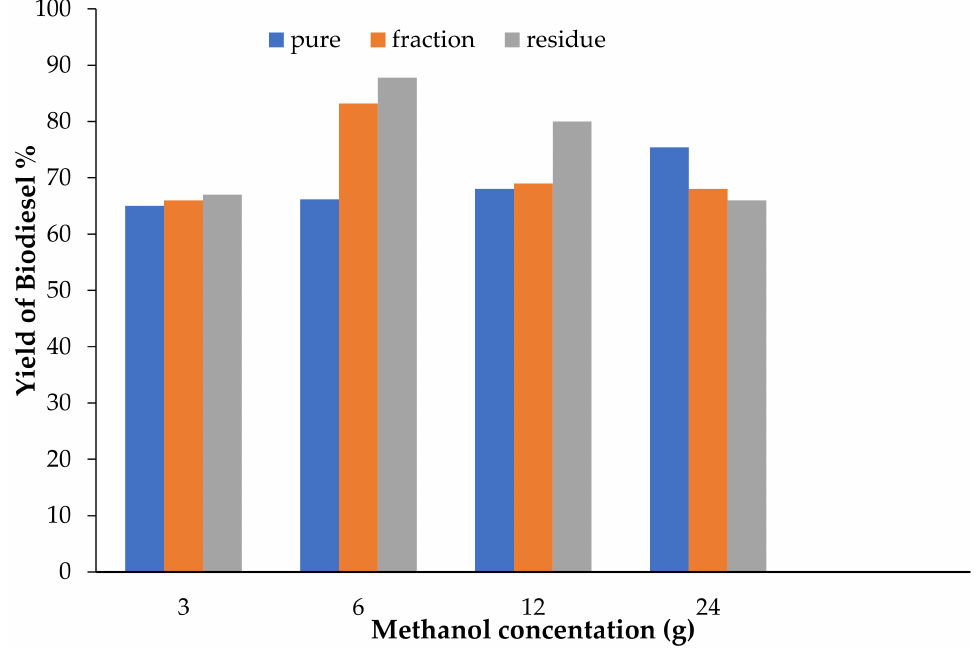
Figure 8. Effect of methanol concentration on the yield of biodiesel produced from interesterified pure oil, fraction of oil, and